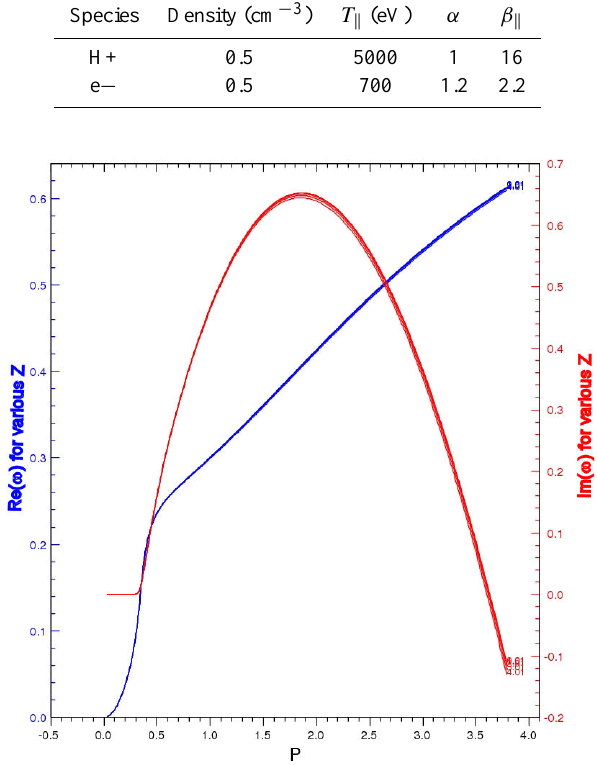
Fig. 9. Results for model 3. Same legend as Fig. 7